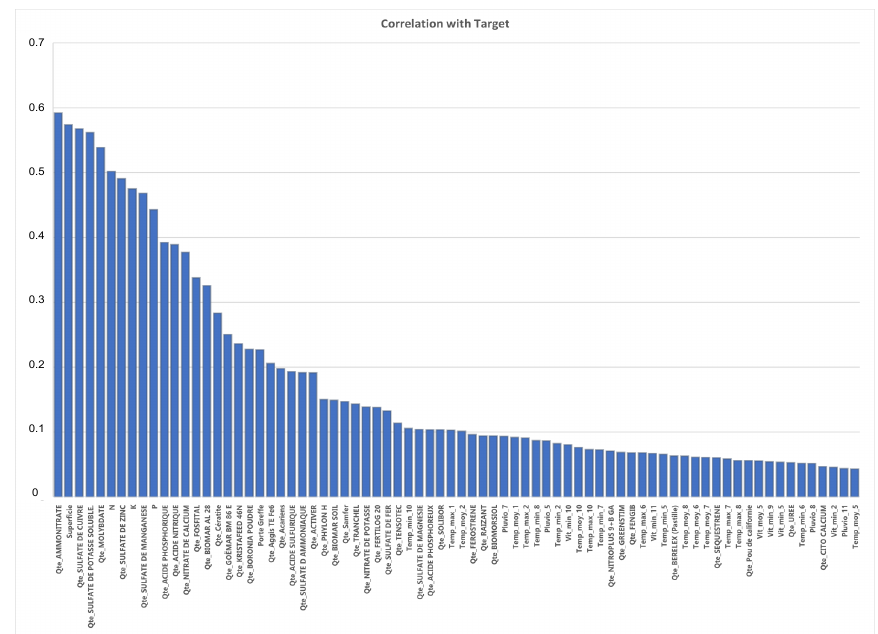
Figure 6. Correlation between input variables and